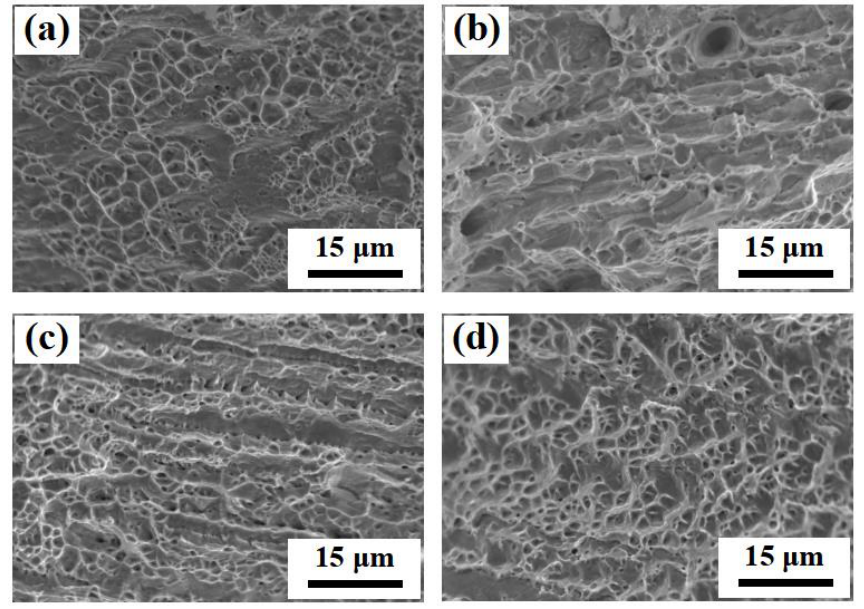
Figure 13. SEM images of the tensile fracture morphologies of the LMD-Al 0.5 FeCoCrNi walls under different heat dissipation rates: ( a ) T-0; ( b ) T-20; ( c ) T-40; ( d ) T-60.